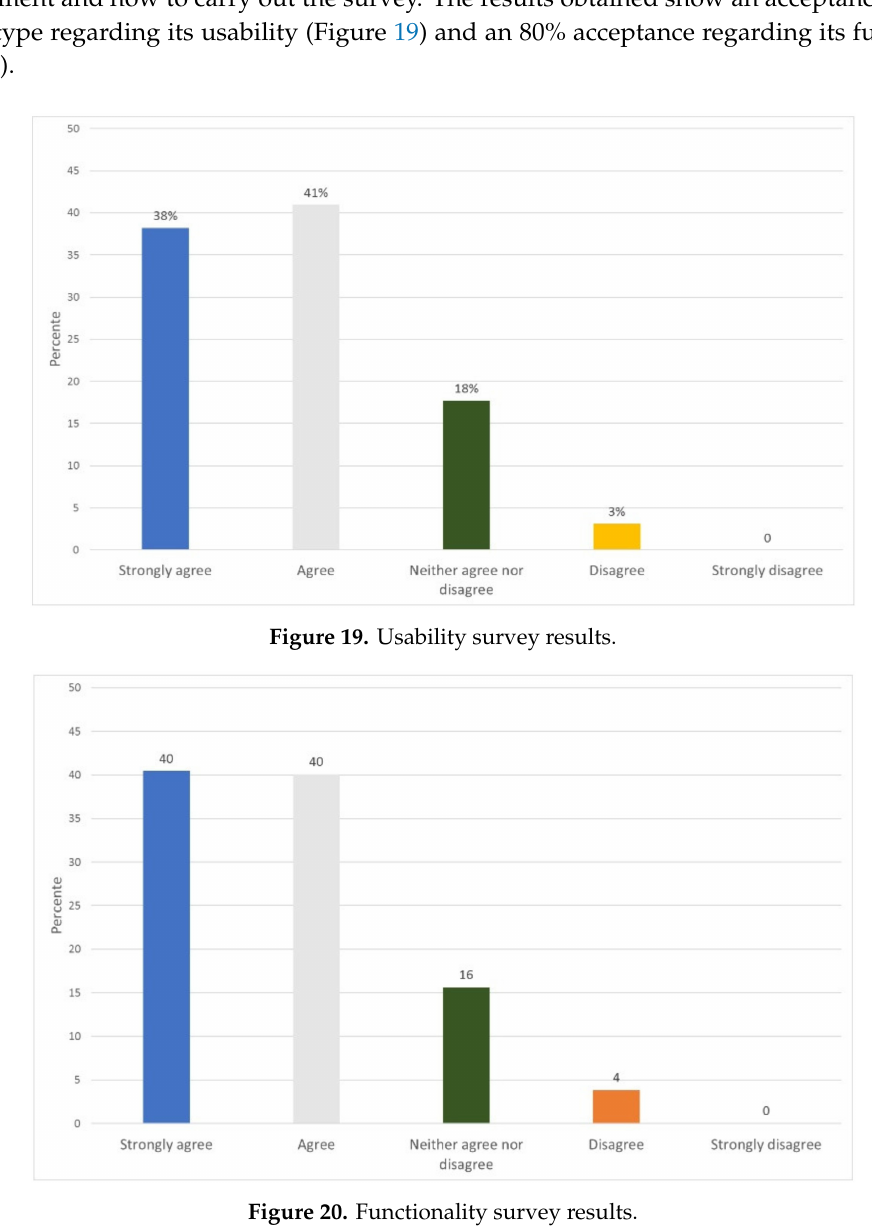
Figure 20. Functionality survey